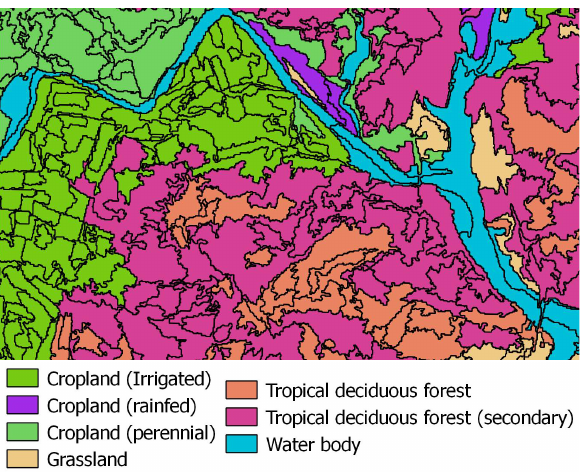
Figure 5: SPOT 5 based updated segmentation (2007).